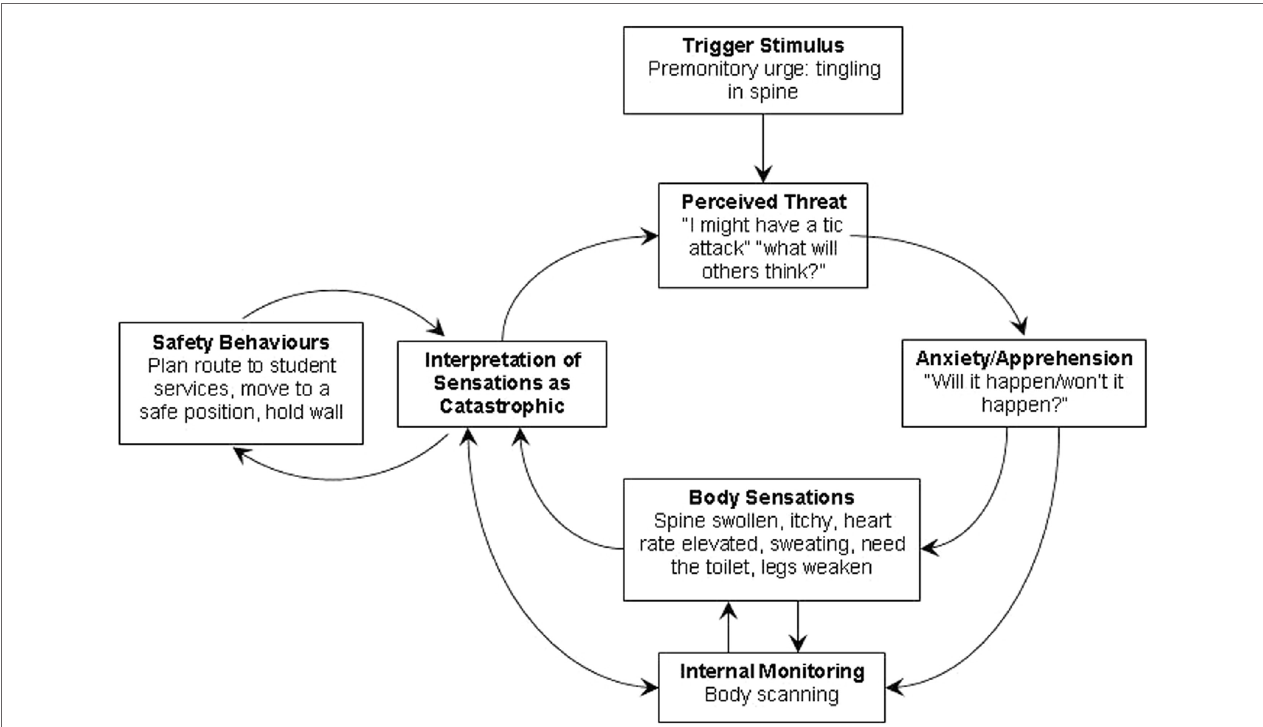
FIGURe 1 | psychological model of tic